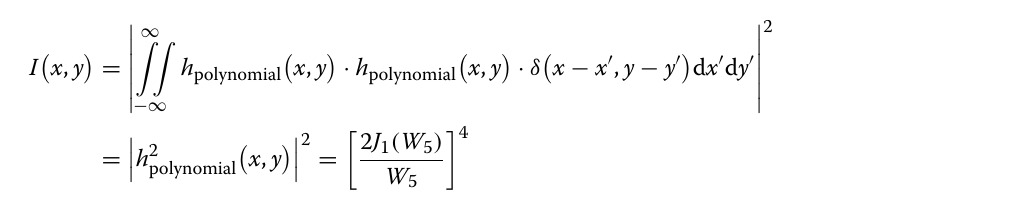
linear aperture of diameter 32 pixels is shown in Fig. 4b. = It is shown that the cut-off spatial frequency is located at W cut-off 0.86, while the normalized PSF corresponding = to the quadratic aperture is shown in Fig. 4c. Improved cut-off spatial frequency is located at W cut-off 0.76. The = comparison with the circular aperture gives greater cut- off spatial frequency at W cut-off 1.0 as shown in Fig. 4d. = The influence of the number of zones upon the PSF is investigated, and the PSF plots are shown in Fig. 5a–h. The PSF corresponding to the first model using the